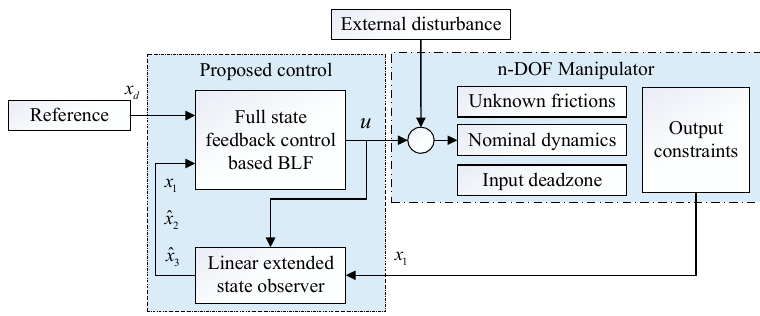
Figure 2. Structure of the proposed control. Figure 2. Structureoftheproposedcontrol. BLF = barrierLyapunovfunction; n-DOF =